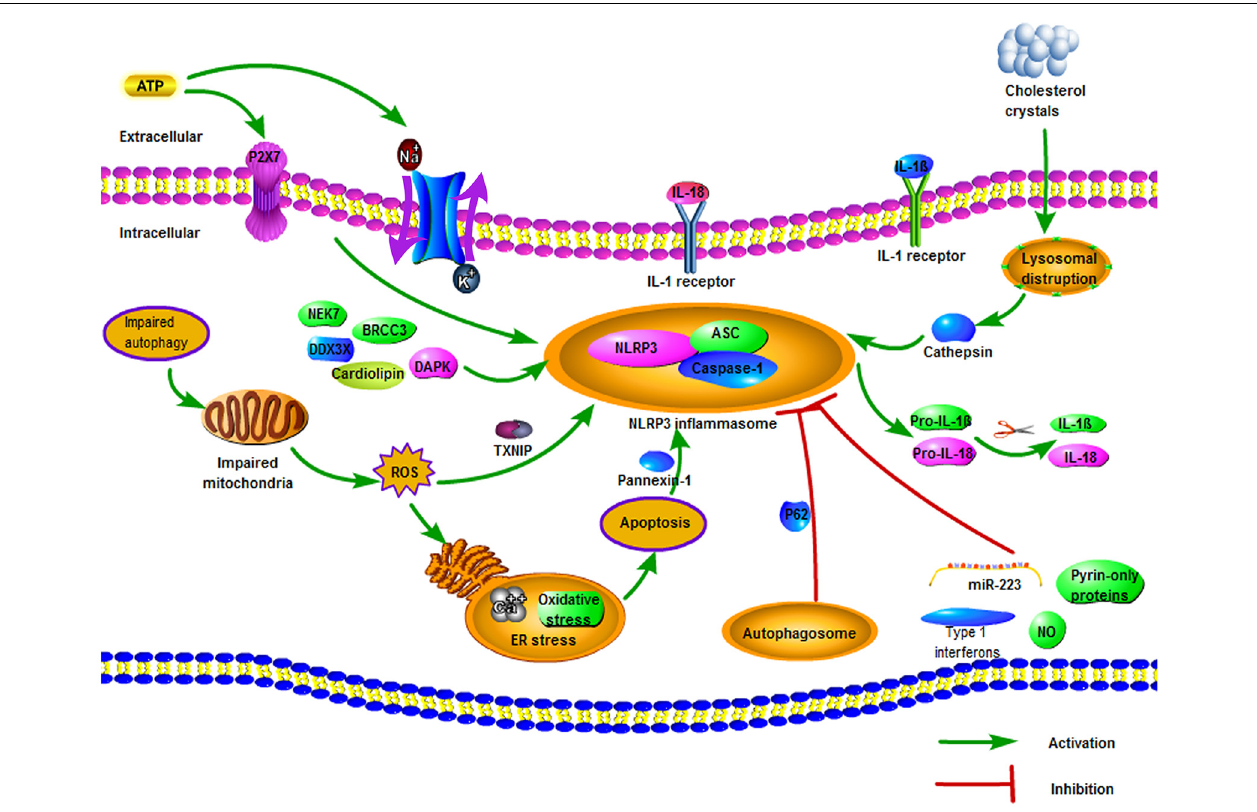
FIGURE 1 | The regulation of NOD-like receptor pyrin domain containing 3 (NLRP3) inflammasome. There are three potential stimuli for NLRP3 inflammasome activation, including reduced intracellular K + concentration, mitochondrial reactive oxygen species (ROS), and lysosomal membrane destruction. Extracellular ATP can promote K + efflux via affecting the function of Na + /K + -ATPase pump and triggering autocrine and paracrine P2X7. Impaired autophagy can increase ROS levels, thereby activating NLRP3 inflammasome and resulting in secretion of Ca 2+ and oxidative stress. Various particulates, such as the cholesterol crystals of atherosclerotic plaque, can disrupt the lysosomal membrane and deliver cathepsin into the cytoplasm, hence activating the NLRP3 inflammasome. Besides, several negative regulation mechanisms of NLRP3 inflammasome are also demonstrated, including autophagy, nitric oxide (NO), miR-223, type I interferons, and pyrin-only